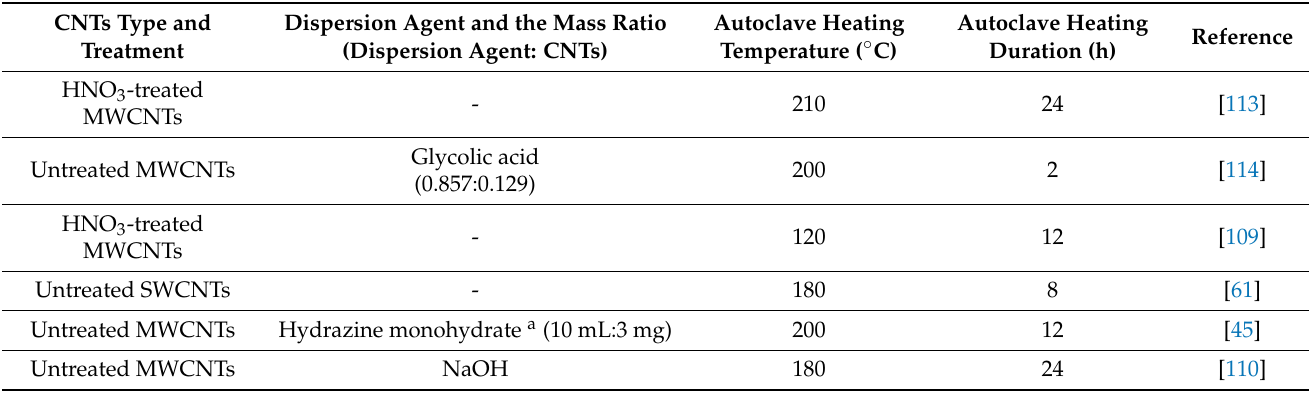
Table 4. Optimized dispersion agent and autoclave heating parameters of hydrothermal processing.